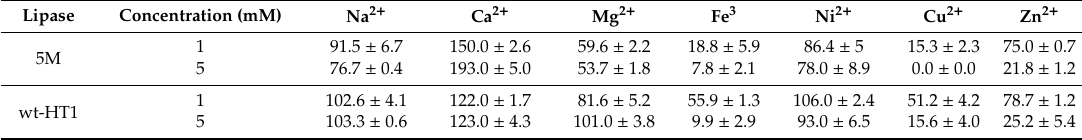
Table 1. The effect of metal ions on enzyme activity of wt-HT1 and 5M mutant lipases. Table 1. The e ff ect of metal ions on enzyme activity of wt-HT1 and 5M mutant lipases.